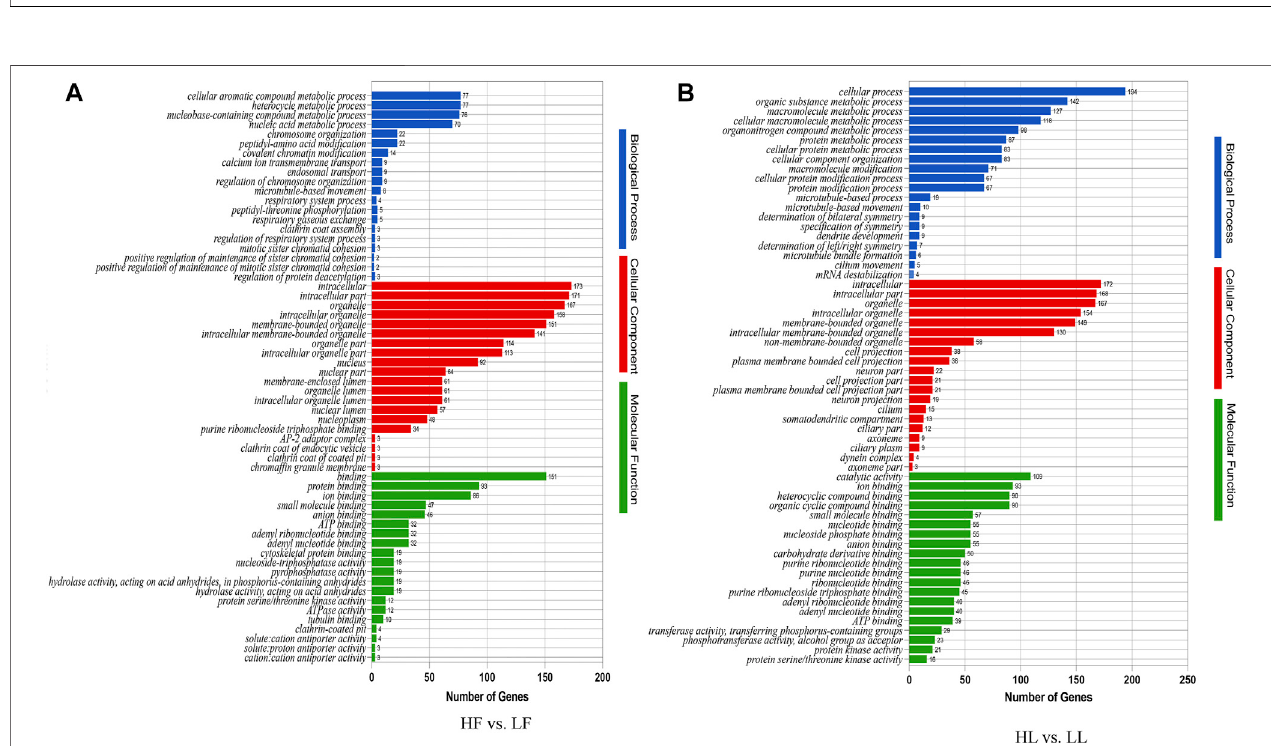
FIGURE 5 | Gene ontology functional enrichment analysis. (A) The enriched GO terms in biological process, molecular function, and cellular component in high- yielding goats inthe follicular phase versus low-yielding goats inthe follicular phase (HF vs. LF). (B) TheGOterms enriched inbiologicalprocess, molecular function, and cellular component in high-yielding goats in the luteal phase versus low-yielding goats in the luteal phase (HL vs. LL). Note. p < 0.05.